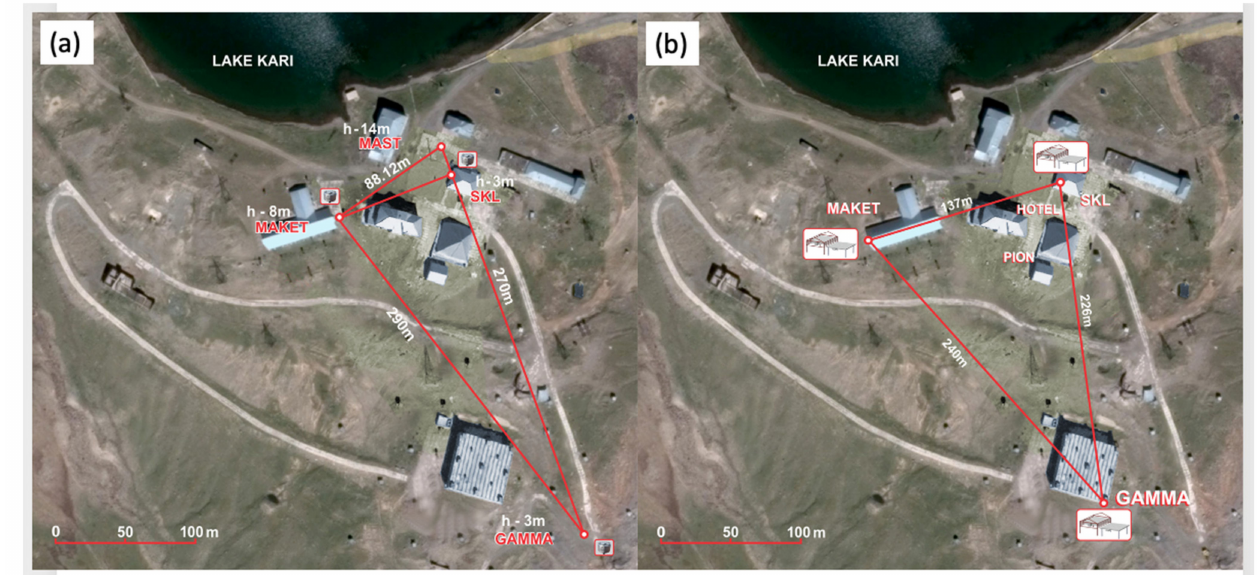
Figure 1. ( a ) EFM 100 electric mills network, near 4 sites the heights of masts are indicated; ( b ) STAND1 particle detector